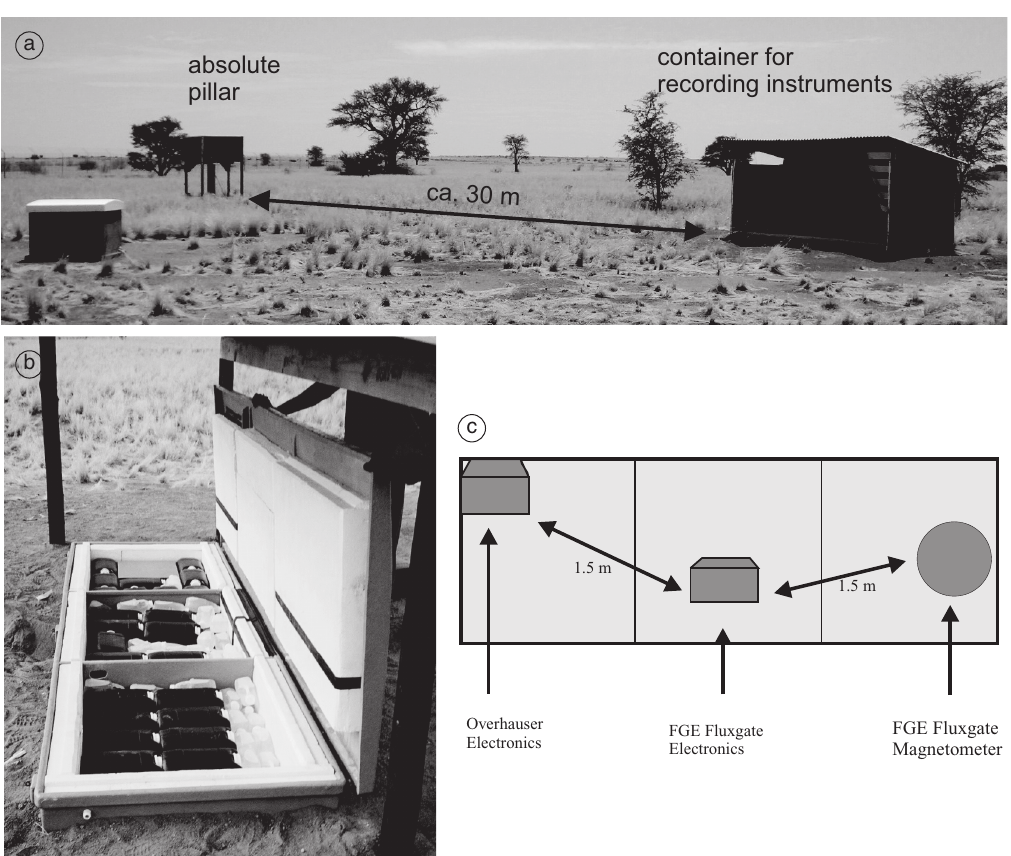
Fig. 5a-c. a) Measurement structures at KMH observatory. b) The container housing the recording equipment with thermal insulation by Styrofoam and water bottles. c) Schematic layout of the instrumentation box show- ing the respective distances between the different electronics systems and the FGE fluxgate magnetometer. The dimensions of the box are approximately 3 m x 1m x 1.5 m. The average distance between the different elec- tronics configurations is 1.5 m to eliminate disturbing interferences between the different